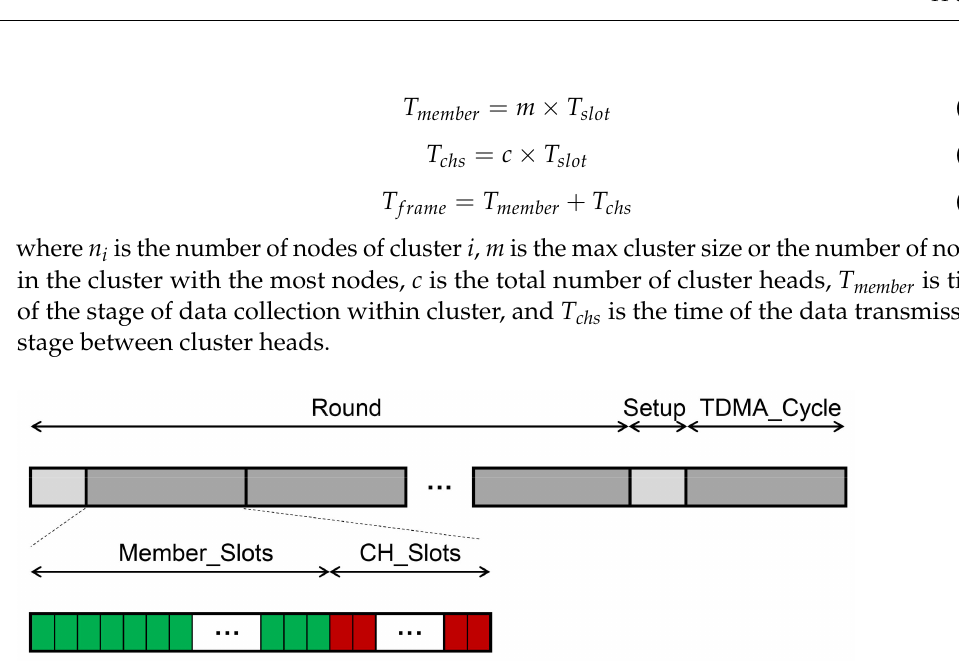
Figure 7. The improved TDMA schedule. The gray grids represent the set-up phase, and the black grids represent the steady-state phase. The green grids indicate the time slots of the member nodes in the cluster, and the red grids indicate the time slots of other cluster